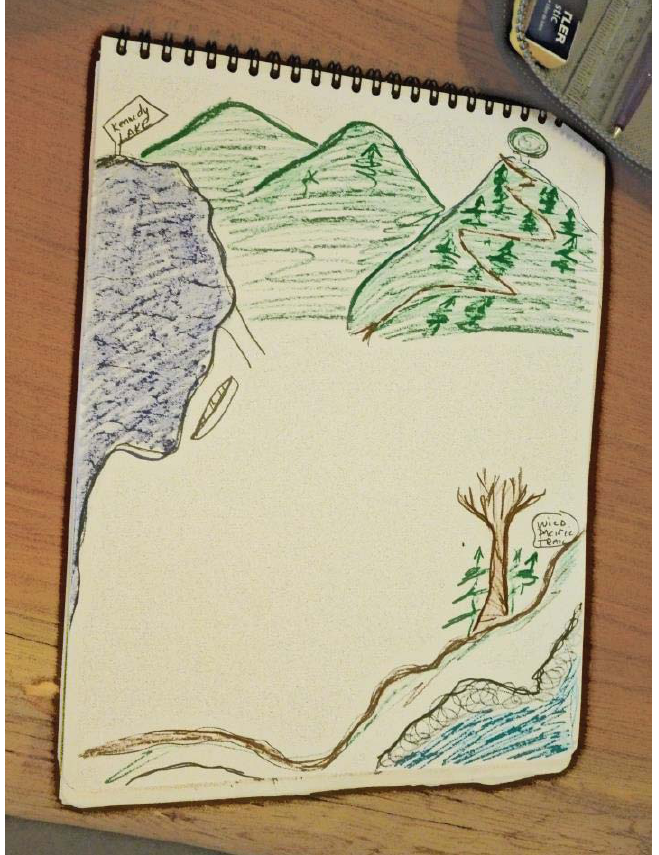
Figure A7 .2: Sample depiction of local ambit—non-First Nations